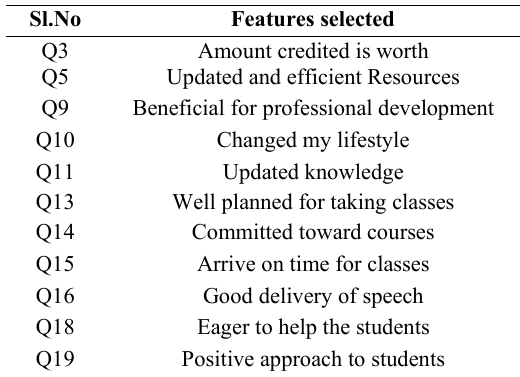
Table 2. Features